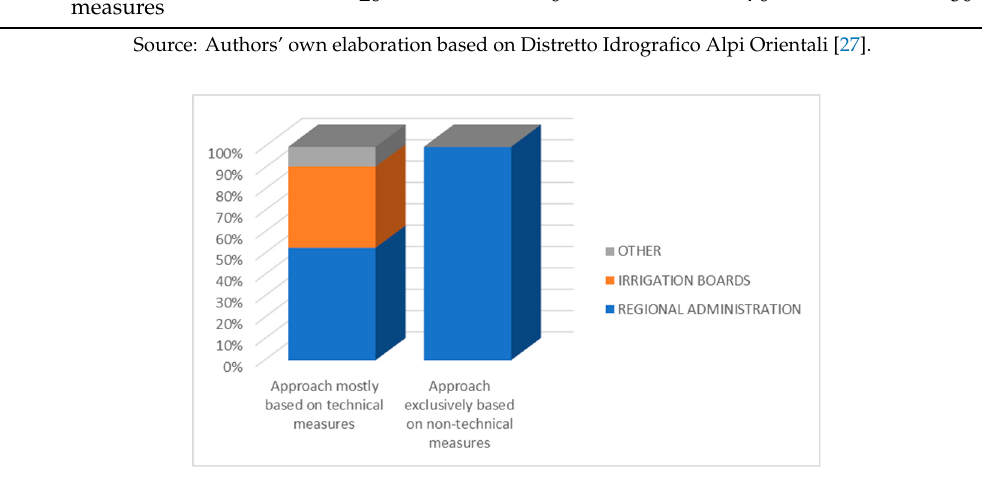
Figure 4. Authorities responsible for measures implementation by approaches (%). Source: Authors’ own elaboration based on Distretto Idrografico Alpi Orientali